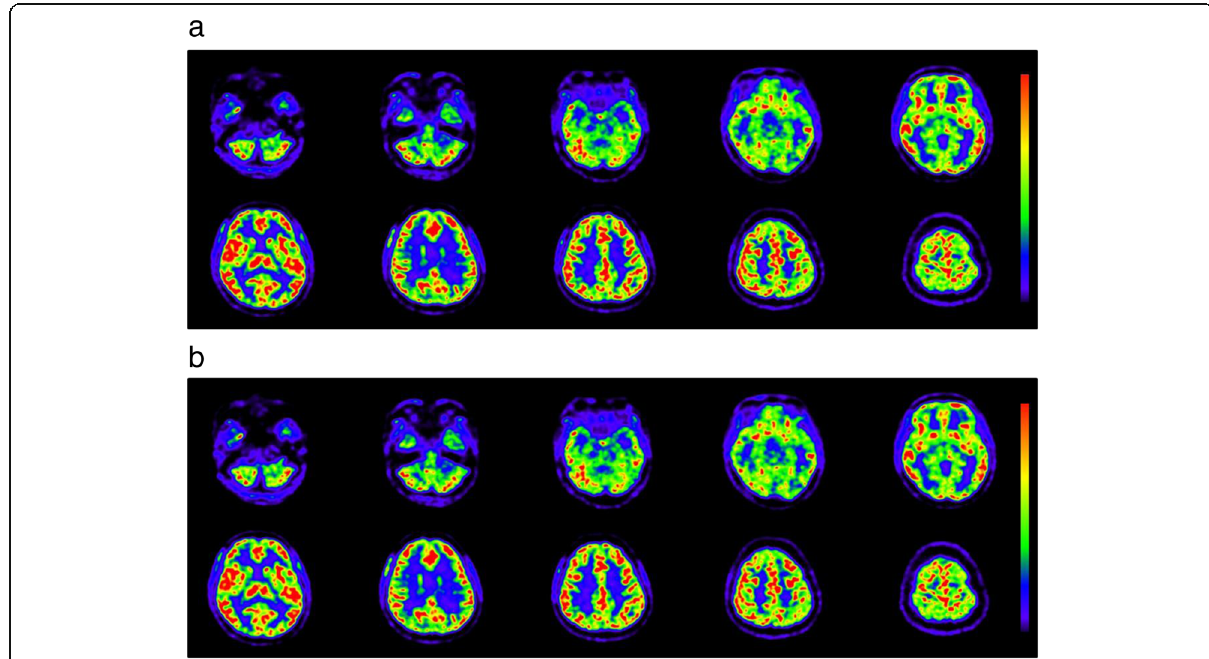
Fig. 4 Representative CBF images calculated from dynamic PET data reconstructed by the AB- ( a ) and ZTE-MRAC ( b ) methods. Color scales in the same range show that the two images are very close and regional values are almost the same